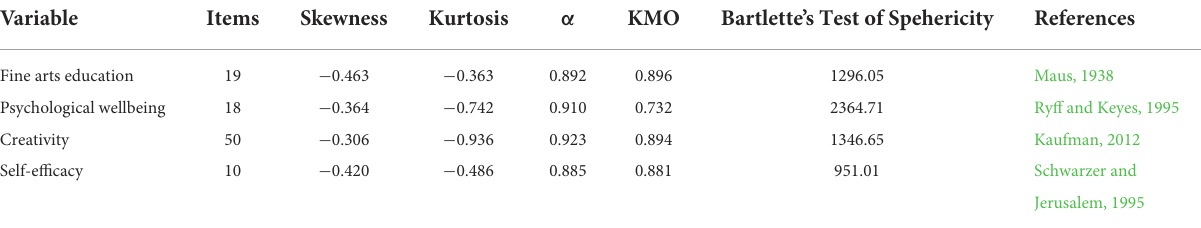
FIGURE1 Theoretical model.